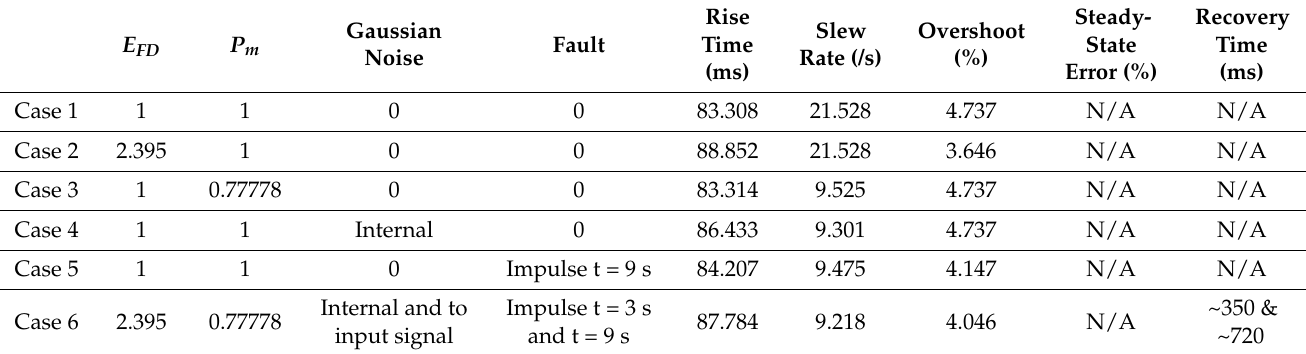
Table 1. Simulation results of the proposed MRAC.